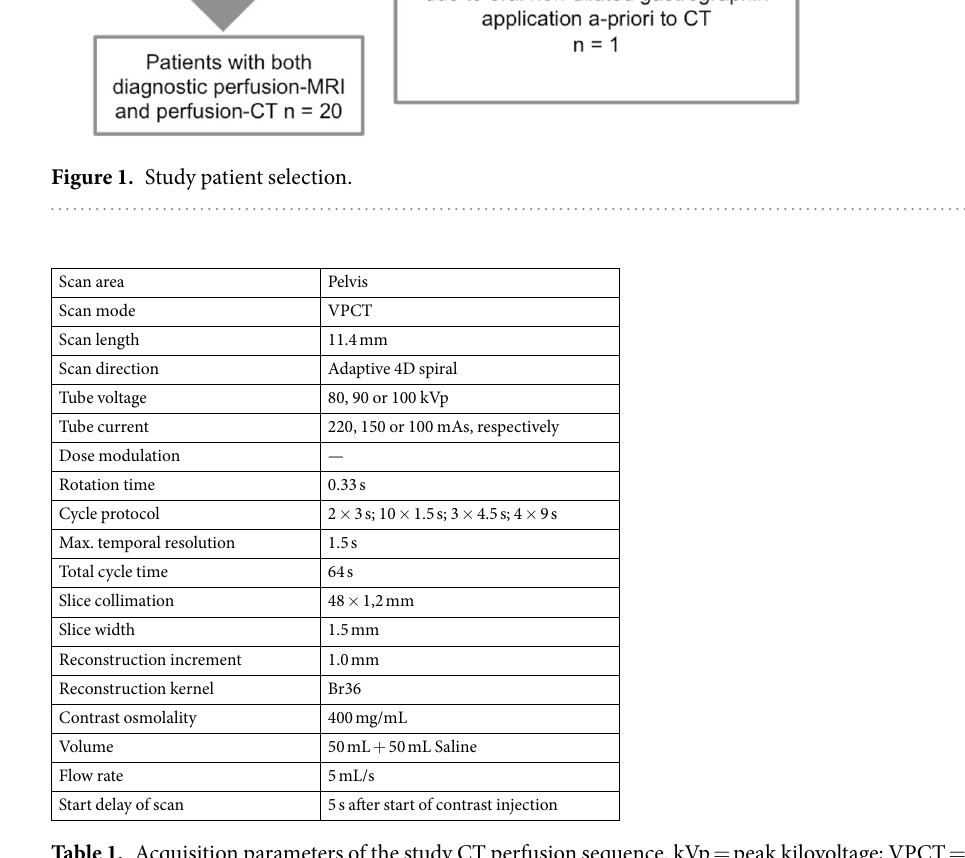
Table 1. Acquisition parameters of the study CT perfusion sequence. kVp = peak kilovoltage; VPCT = volume perfusion